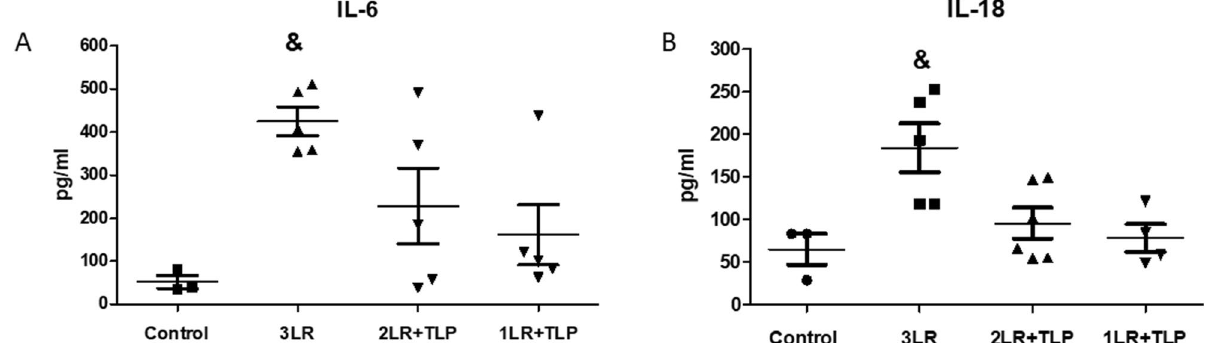
Figure 6. Cytokine levels in renal tissue at 24 h after hemorrhagic shock induction. Interleukin (IL)-6 ( A ) and IL-18 ( B ). & P < 0.05 vs. the other groups. Control, no intervention; 3LR, induction of hemorrhagic shock, followed by infusion of lactated Ringer’s at 3 times the volume of the blood withdrawn; 2LR + TLP, induction of hemorrhagic shock, followed by infusion of lactated Ringer’s at 2 times the volume of the blood withdrawn, together with intravenous injection of terlipressin at 10 µg/100 g body weight; 1LR + TLP, induction of hemorrhagic shock, followed by infusion of lactated Ringer’s at a volume equal to that of the blood withdrawn, together with intravenous injection of terlipressin at 10 µg/100 g body weight.